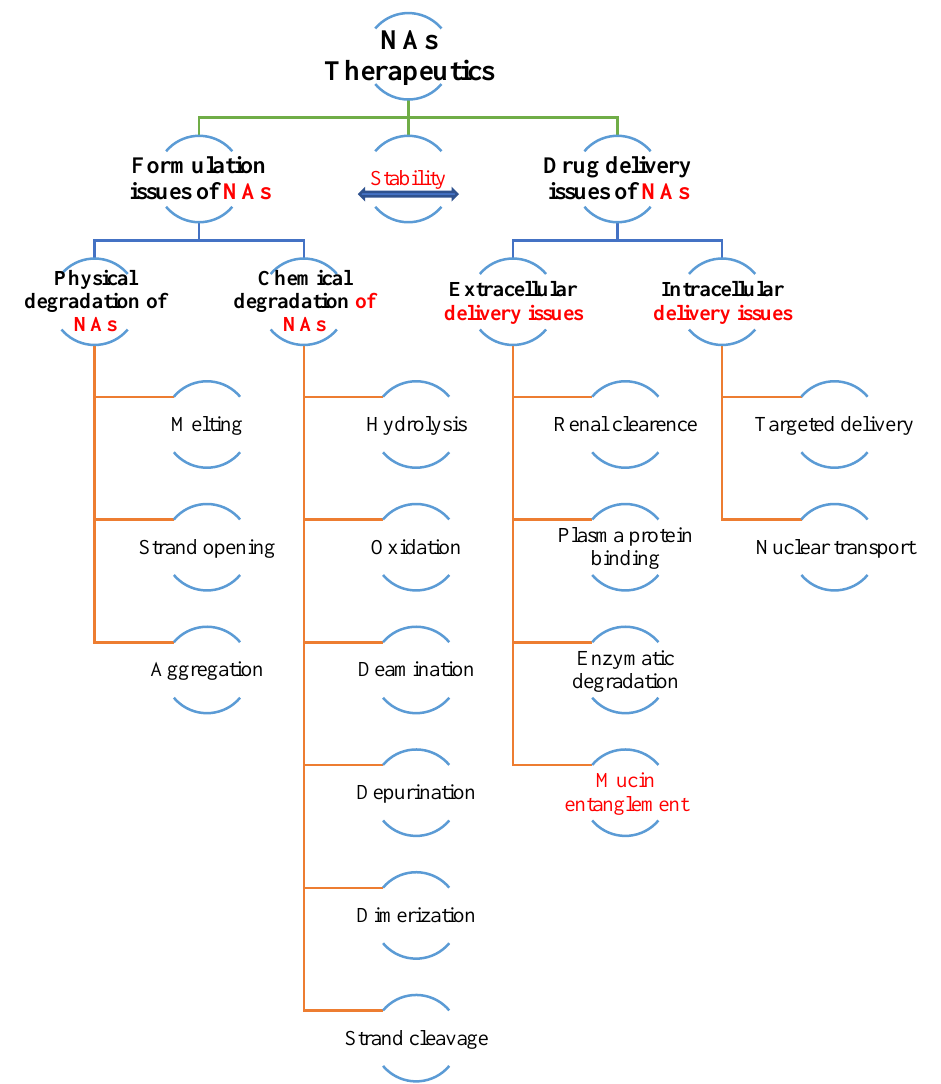
Figure 1. Challenges in the formulation and delivery of NA therapeutics [34].